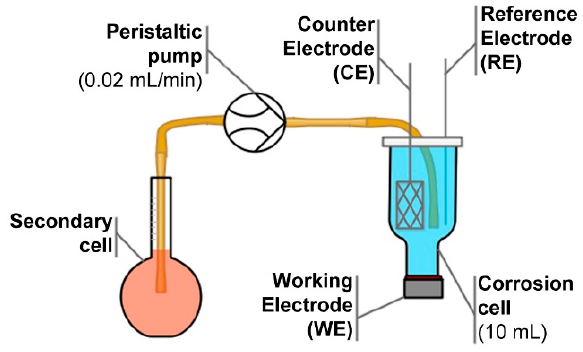
Figure 2. Schematic representation of the setup used during electrochemical studies.